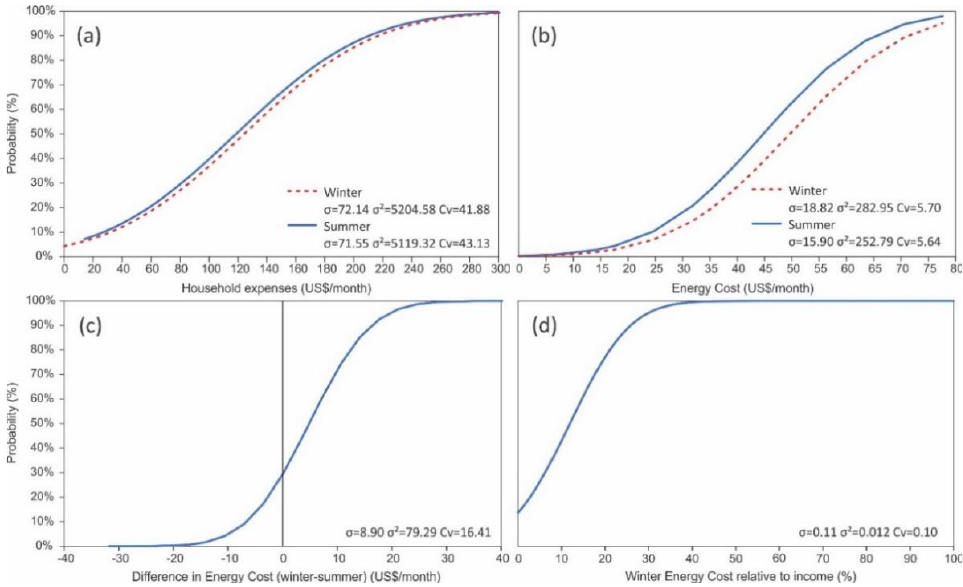
Figure 7. Accumulated distribution of household expenses ( a ), energy cost; ( b ), difference in energy cost between winter and summer; ( c ) and percentage of energy cost in winter versus income ( d ). Based on this, it is considered that using the Minimum Income Standard (MIS) in D4-I1, established by RedPE based on EPL [22,39], and the income and expenditures declared by the household, is relevant to identify households in EP [15,16]. On the other hand, the under-expenditure in energy (D4-I2) has been determined from the median of the group of households in the sample, which belongs to the first eight income deciles. The indicator has identified 75 households whose energy expenditure was below half the median of energy poor household expenditures. It has been seen that D4-I2 is complex to apply and, in combination with the other indicators, it is unable to identify as energy poor those homes that are below the equivalent poverty line (see Table 9). For this reason, the inclu- sion of a new indicator, D4-I3, is proposed (see Table 8), related to said situation so that those homes, despite not being in EP according to other indicators, are classified as energy poor on being below the EPL, and therefore, not including D4-I2 as this does not increase the overall sensitivity of the indicator. Table 9. Results of Original and Adapted EPTTI indicators, considering Chile’s Equivalent Poverty Line. Indicator